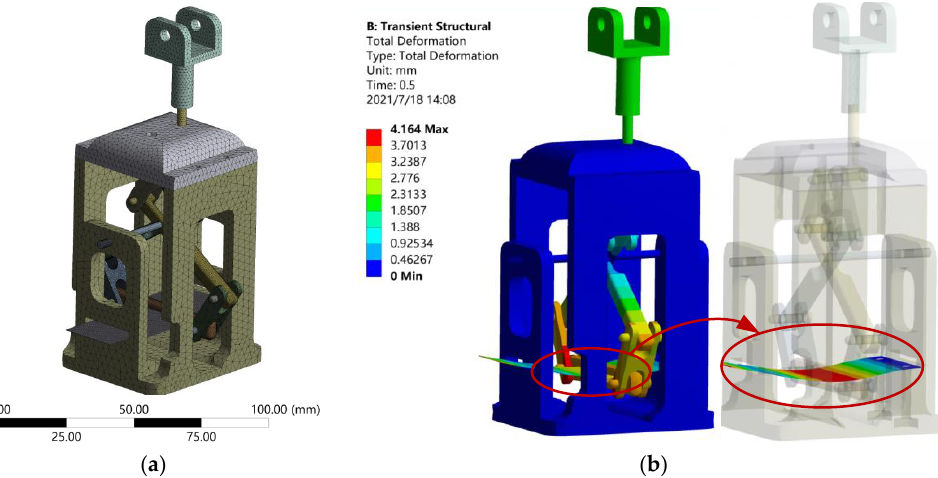
Figure 4. Finite element analysis of the micro-power piezoelectric generator. ( a ) Meshing model; ( b ) deformation diagram. Table 2. Deformation displacement of the flexure strip.